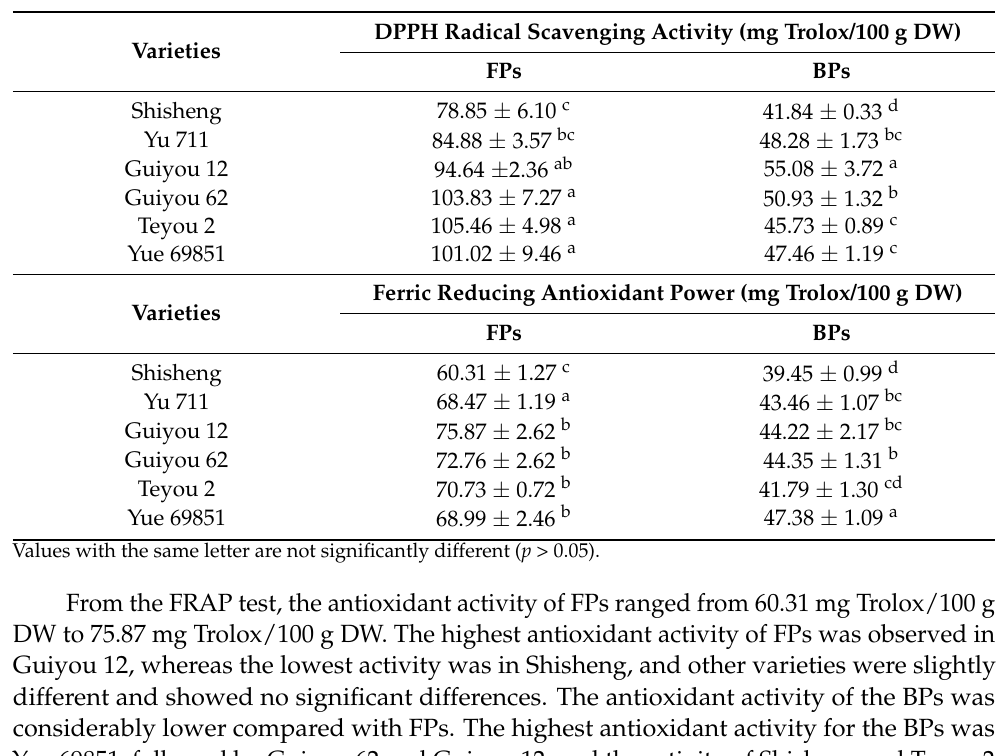
Table 3. Antioxidant capacity of FPs and BPs in mulberry